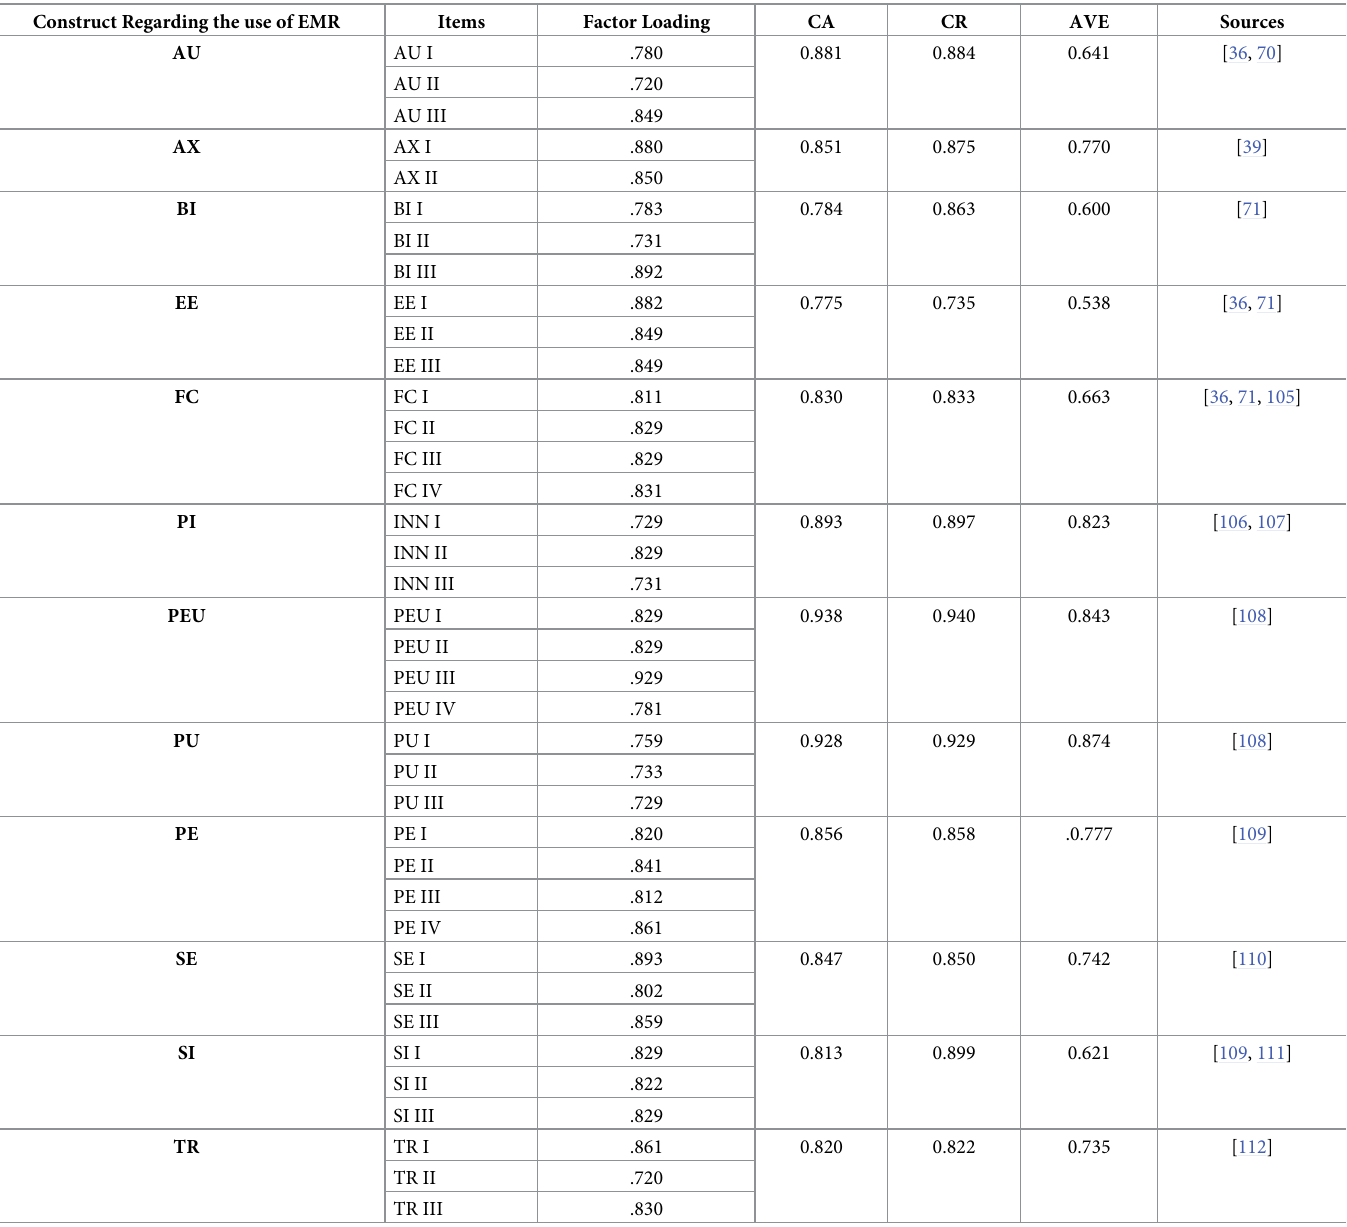
Table 3. Convergent validity results assuring acceptable